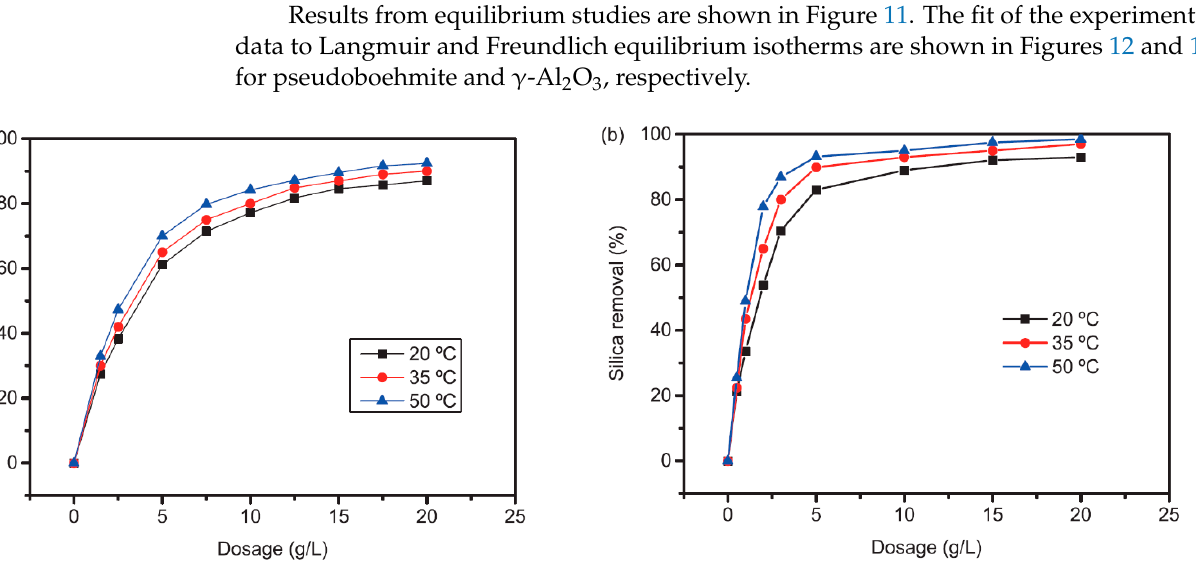
Figure 10. Analysis of experimental data with Boyd model for ( a ) pseudoboehmite ( b ) γ -Al 2 O 3 (experimental conditions: initial pH 8.5, dosages and temperatures in the legend).